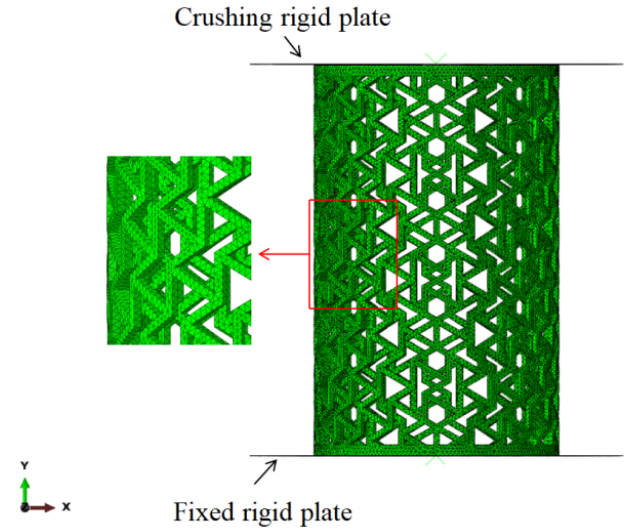
Figure 8. Finite element model and boundary conditions of [30°/ − 30°] RHCS.